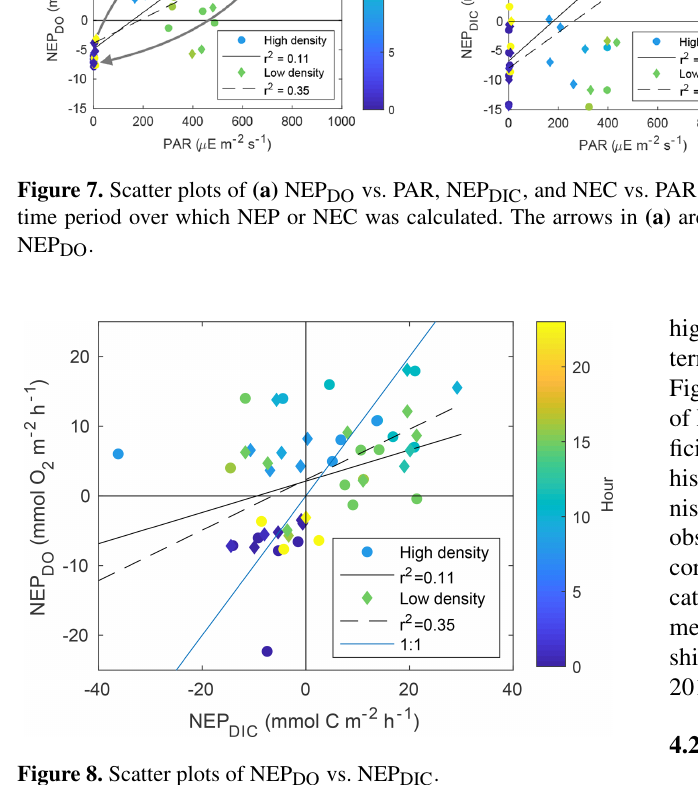
Figure 8. Scatter plots of NEP DO vs. NEP DIC